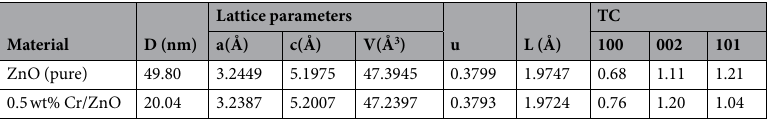
Table 2. The XRD data for the ZnO (pure) and 0.5 wt% Cr/ZnO films; the texture coefficient (TC), the crystallite size (D), the lattice parameter (a, c and volume of the unit cell V), u parameter, and Zn-O bond length (L).